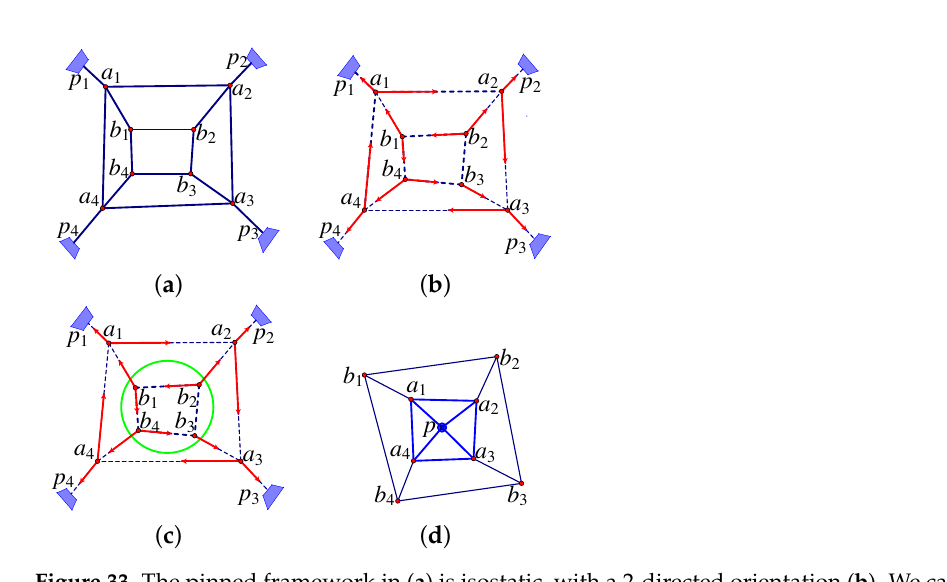
Figure 33. The pinned framework in ( a ) is isostatic, with a 2-directed orientation ( b ). We can see a separating set of directed edges ( c ). If we identify all the pins ( d ), pulling them to the center, then this becomes dependent but only the central part is in the circuit.